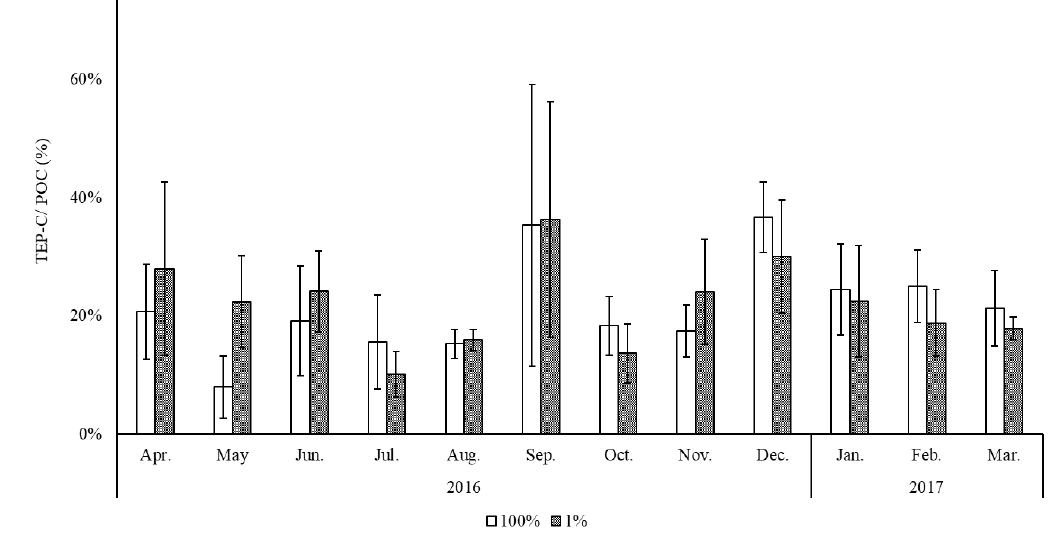
Figure 3. Monthly TEP-C contributions to POC at different light depths (100 and 1%) in Jaran Bay. The monthly mean specific and absolute carbon uptake rates of the phytoplankton in the water column during this study are presented in Table 2. The specific carbon uptake rates were 0.001–0.112 h − 1 at the 100% light depth and 0–0.004 h at the 1% light depth. The absolute carbon uptake rates were (Table 2). The hourly specific and absolute carbon uptake rates were relatively higher in the surface from the surface to a 1% light depth (primary production of phytoplankton from the euphotic layer) − 2 − 1 ranged from 3.0 to 274.1 mg C m h (mean ± S.D. = 34.5 ± 45.2 mg C m primary production was recorded in the early summer (mean ± S.D. = 115.4 ± 97.3 mg C m July 2016) and the lowest value was measured in the summer (mean ± S.D. = 5.7 ± 2.3 mg C m August 2016) (Table